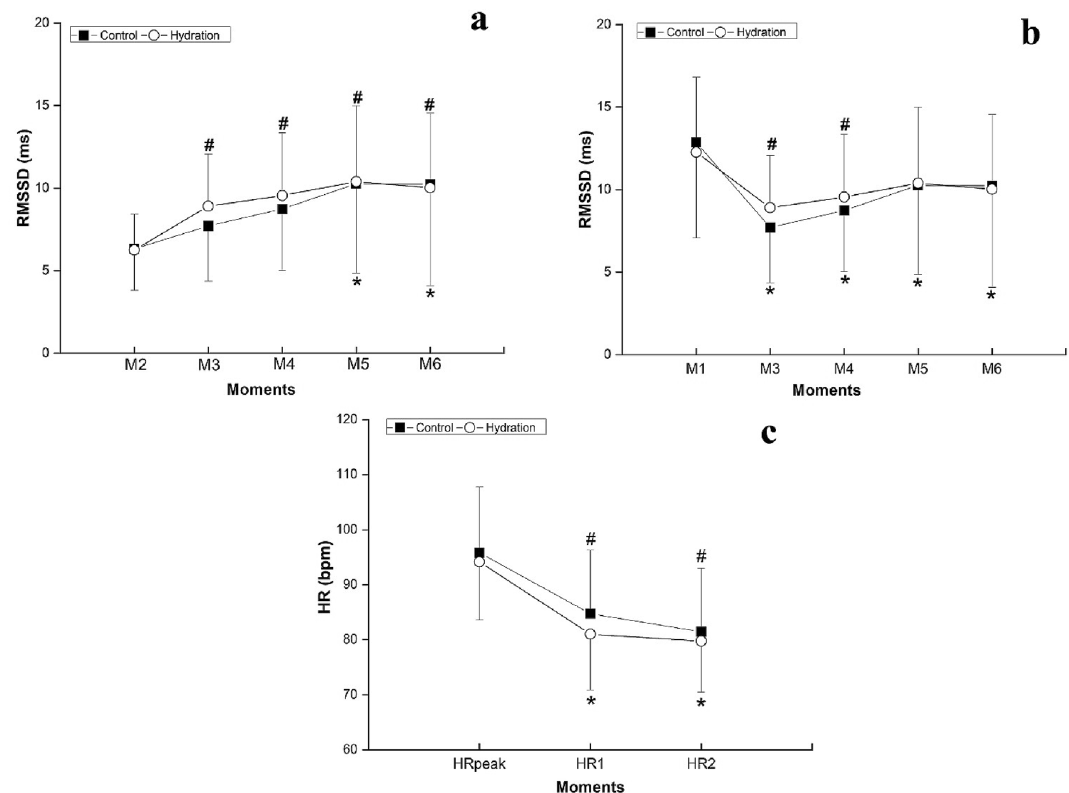
Figure 2. Comparison of RMSSD 30 at exercise ( a ) and initial rest ( b ) and comparison between HRpeak and HR1 and HR2 ( c ). Legend: M1 = last 30 s of initial rest; M2 = last 30 s of exercise; M3 = 0–30 s, M4 = 30–60 s, M5 = 60–90 s, M6 = 90–120 s of recovery; HRpeak heart rate at the peak of exercise, HR1 heart rate after 1 min of recovery, HR2 heart rate after 2 min of recovery. *Difference between exercise ( a )/initial rest ( b ) and recovery on control protocol ( p value < 0.001); #Difference between exercise ( a )/initial rest ( b ) and recovery on hydration protocol ( p value < 0.05).